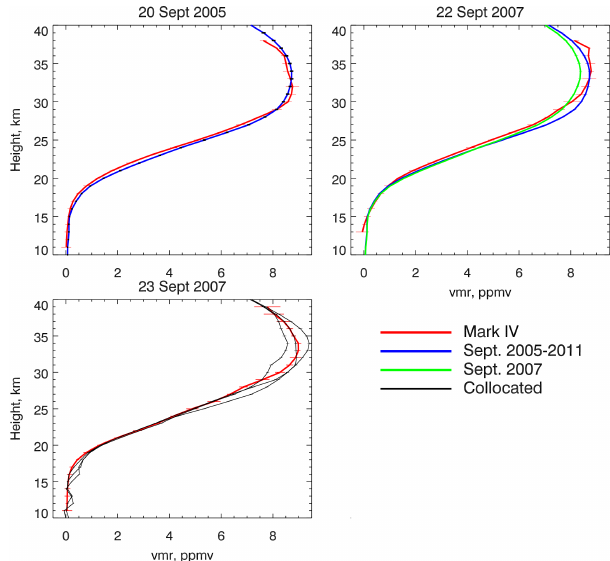
Figure 12. MkIV and MIPAS O 3 vmr vertical profiles – collocated profiles when they exist, otherwise the mean profiles from Septem- ber 2007 and the September months of 2005–2011 in the 30–40 ◦ N latitude band where the three balloon flights took